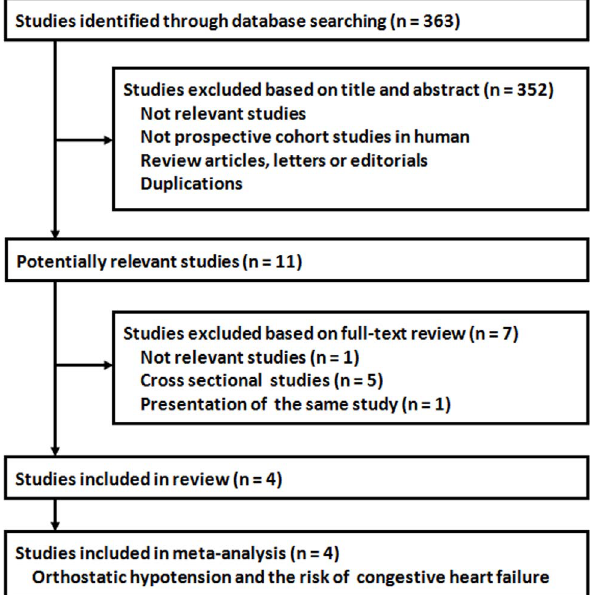
Figure 1. Search and selection of studies included in the meta-